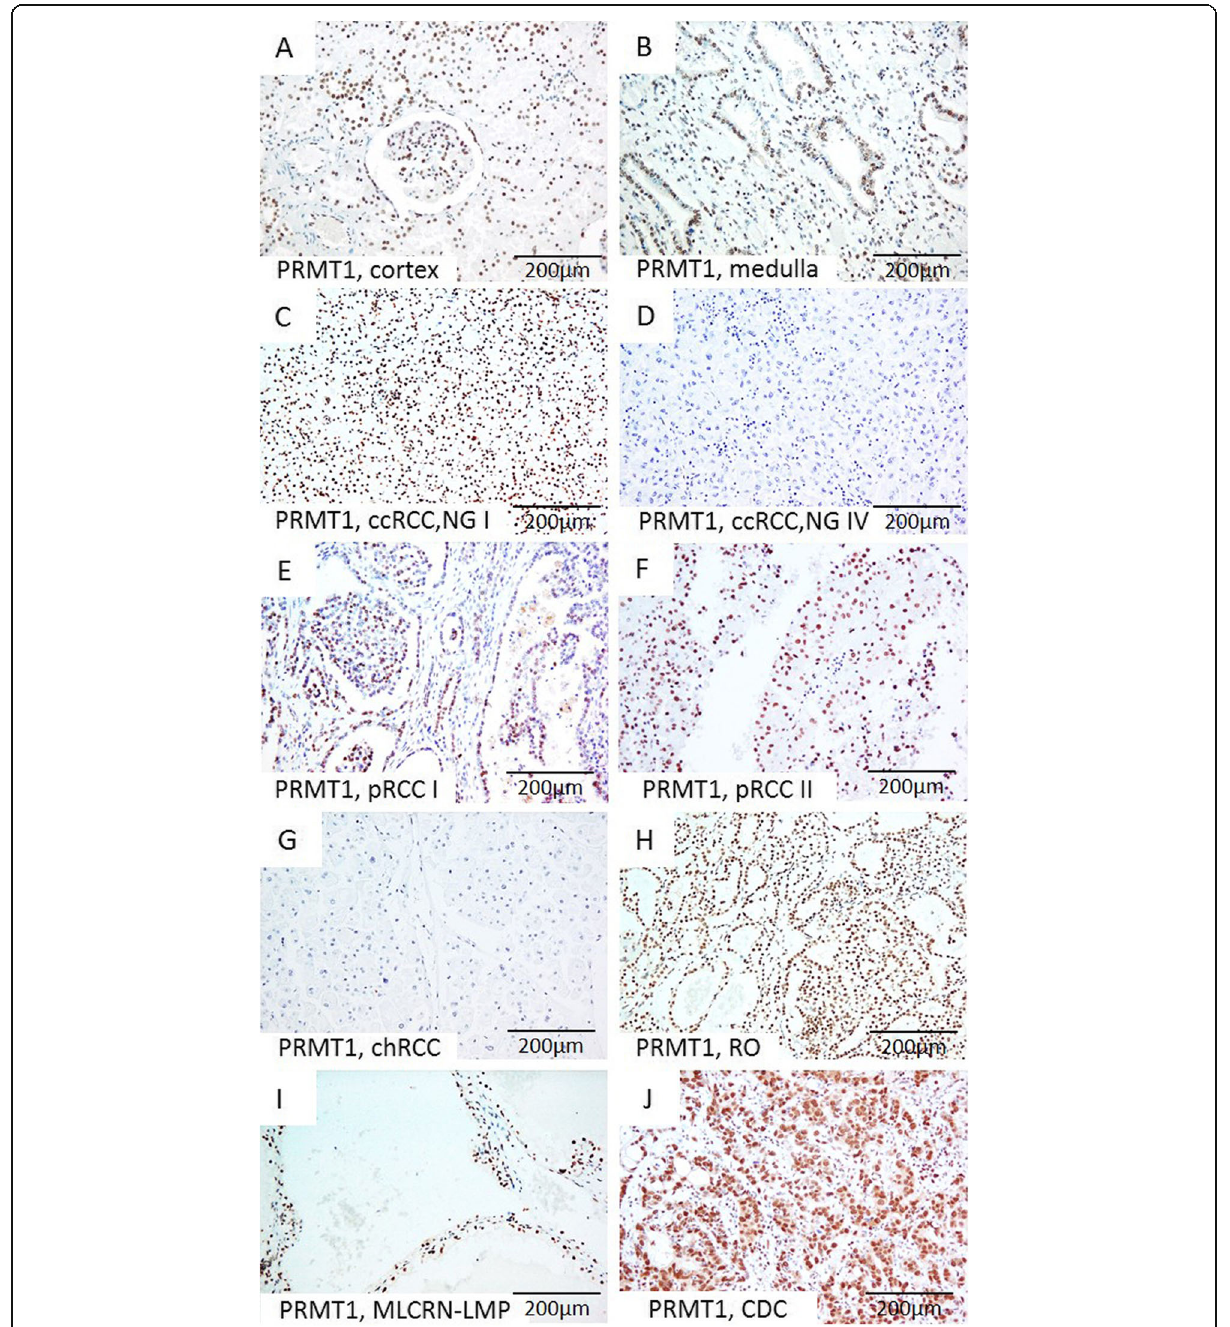
Fig. 1 Representative microscopic photographs of PRMT1 expression in non-tumor renal parenchyma ( a - b ) and various RCT ( c - j ). (a ) Cortex, ( b ) Medulla; ( c ) Diffuse strong nuclear positivity in low-grade ccRCC, ( d ) Negative immunostaining in high grade ccRCC; ( e - f ) Strong nuclear expression in pRCC, type I and pRCC, type II, respectively, ( g ) Absence of expression in chRCC, in contrast to ( h ) strong diffuse nuclear positivity in RO, ( i - j ) Positive staining in MLCRN-LMP and CDC, respectively. Original magnification, ×200. Abbreviation: NG-nuclear